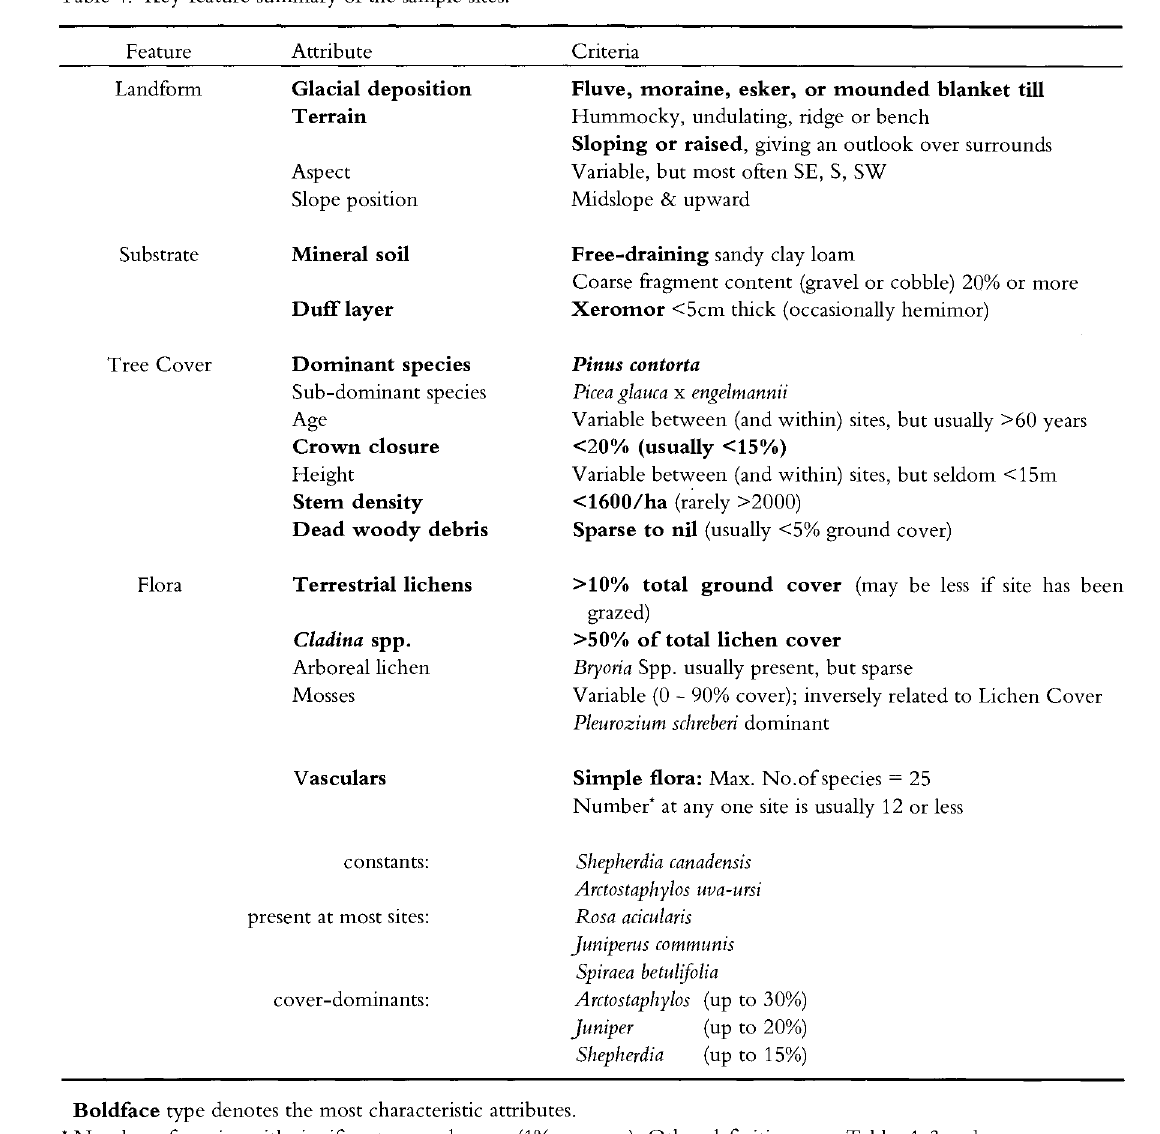
Table 4. Key-feature summary of the sample sites. Feature Criteria